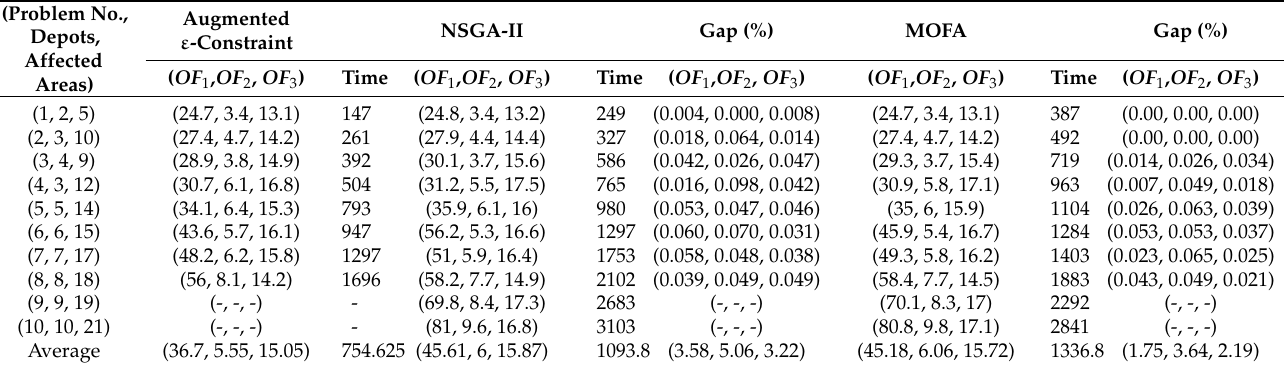
Table 4. The best values of the augmented ε -constraint method, NSGA-II and MOFA.